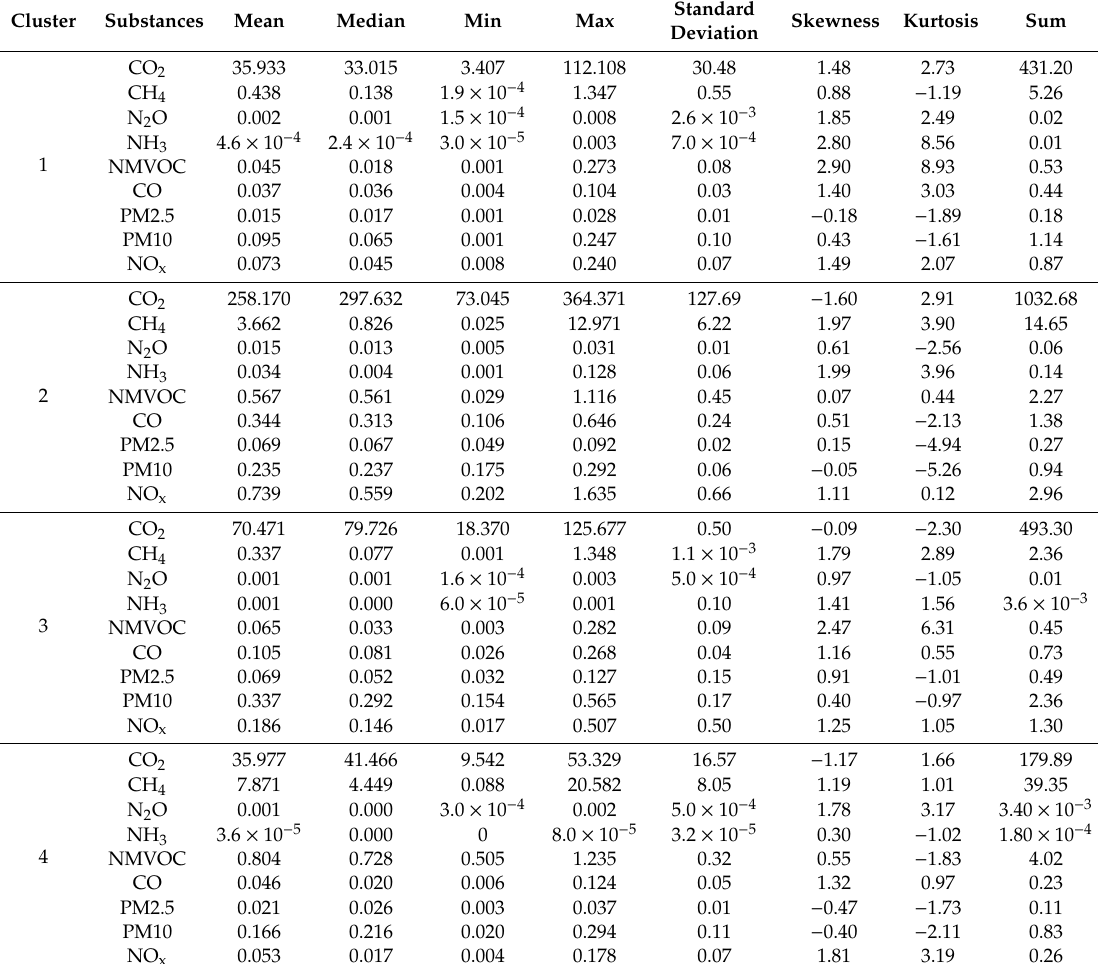
Figure 8. Topological map for individual similar groups of the EU countries (own elaboration). Table 12. Results of the statistical analysis regarding the emission of harmful substances compared to the number of inhabitants for individual clusters of the EU countries (own elaboration).